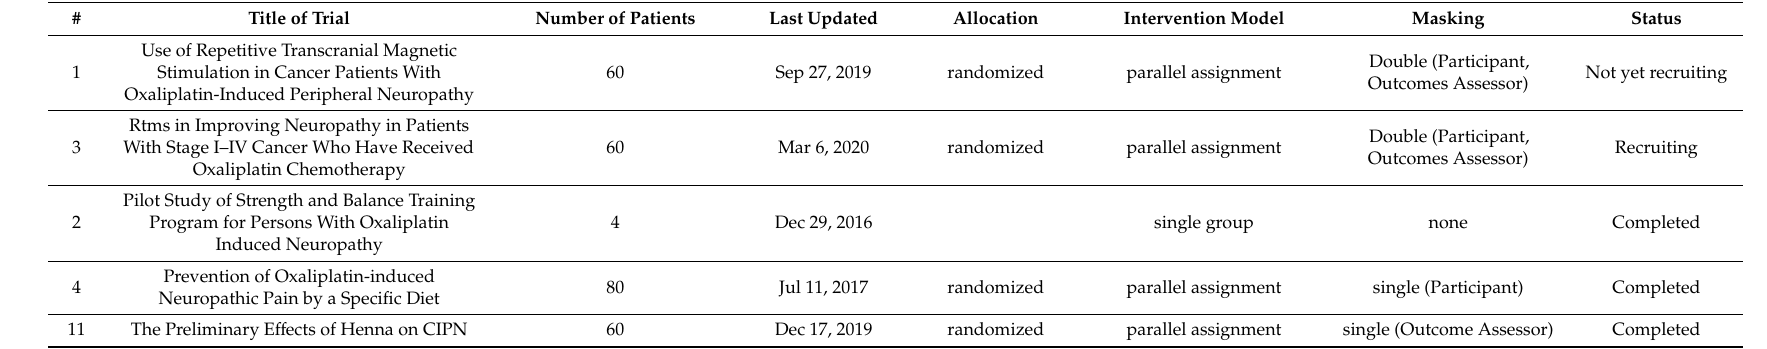
Table 2. Non-pharmacological studies including oxaliplatin-treated patients registered at ClinicalTrial.gov on 1 April